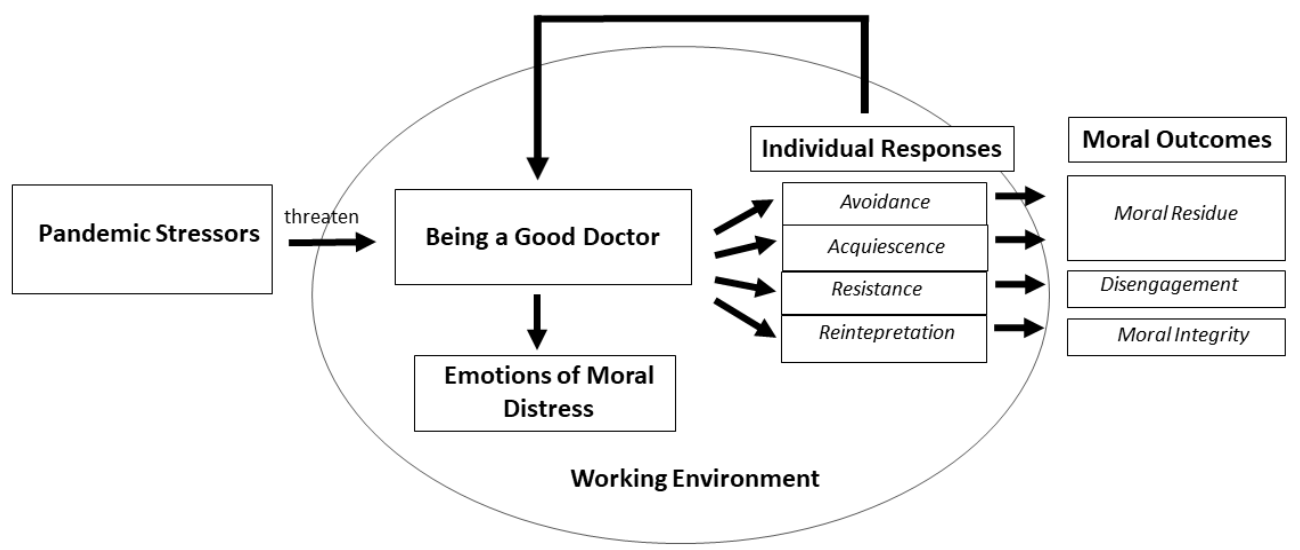
Figure 1. Model of the moral distress process during COVID-19 pandemic. Being a Good Doctor meant different things for different physicians: to cure patients, to be informed and/or prepared, to guide relationships with families. Regardless of what each participant meant for being a good professional, the Pandemic Stressors represented challenges for all. Pandemic Stressors included limited healthcare resources, intensified patient triage, changeable selection criteria, limited therapeutic/clinical knowledge, and patient isolation. Pandemic Stressors threatened the sense of Being a Good Doctor, gener- ating moral distress. Emotions of Moral Distress were powerlessness, frustration, anger, and sadness. Physicians described different Individual Responses to moral distress, such as avoidance, acquiescence, resistance, and reinterpretation. These responses may or may have not succeeded in restoring the sense of Being a Good Doctor, and therefore generated different Moral Outcomes, such as moral residue, disengagement, or moral integrity. In addition to Individual Responses, the Working Environment, especially the team and per- ceived organizational culture, was instrumental in influencing the Moral Outcomes. In the sections below, the categories of the model are described, and illustrative quotes are reported from the interviews. The quotes are followed by the participant number. 3.2.1. Pandemic Stressors Limited Healthcare Resources. One of the main factors that caused moral distress was the experience that resources were woefully inadequate: not enough oxygen, not enough ICU beds, not enough physicians. The stressful experience of working with limited resources was a difficult shift, and fostered the sense of not providing good care. “ We didn’t have any more beds in the ICU, we found ourselves distributing opioid to do palliative care to people who normally we would have saved ” . # 12. Intensified Patient Triage. In the context of limited healthcare resources, physicians were confronted with the struggle of triaging patients. Although the experience of triage was familiar to many, it was extraordinarily difficult because of the sheer vol- ume of consequential decisions to make, and triage criteria that differed from pre- pandemic standards. “ There was a time during which we assessed nearly 250 patients a day…We lowered the standard of care at that point and that was difficult for me to bear. ” # 6. “ I felt like a judge who should play God and say: «You live, you die». I became like a robot to survive.” #2. Changeable Selection Criteria. Another distressing factor was the lack of consistency of the selection criteria due to the rapid changes in knowledge about the disease, or